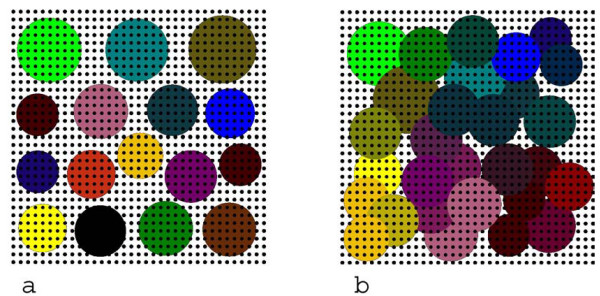
Conceptual coding schemes for the assignment of binding sequences to TFs. Binding sequences are displayed as points, TFs as colored spheres. Colors correspond to the biological function of each TF. a) A sphere-packing code – code-words are covered by non-overlapping spheres. The TFs do not share binding sequences. b) A smooth code – code-words are covered by overlapping spheres with similar function. TFs can share binding sequences with neighbor TFs. This type of code is predicted to be smooth, that is where TFs with shared binding sequences tend to have similar biological function, represented by spheres of similar color in the figure.